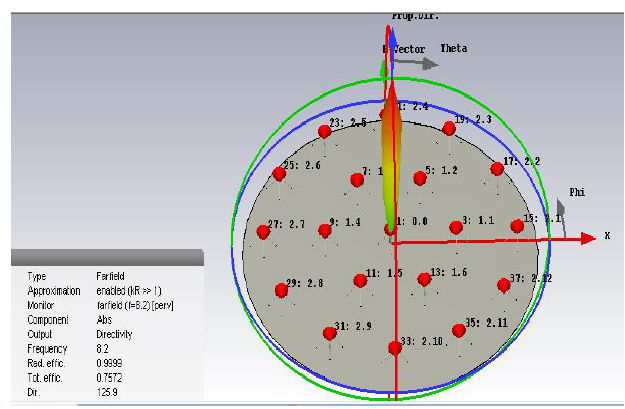
Fig. 5. Model of a circular concentric antenna array made of turnstile emitters.